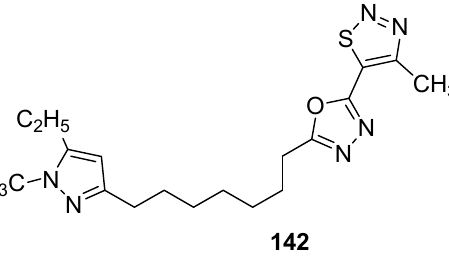
Figure 26. Structures of commercial antifungal drugs 138–140 .